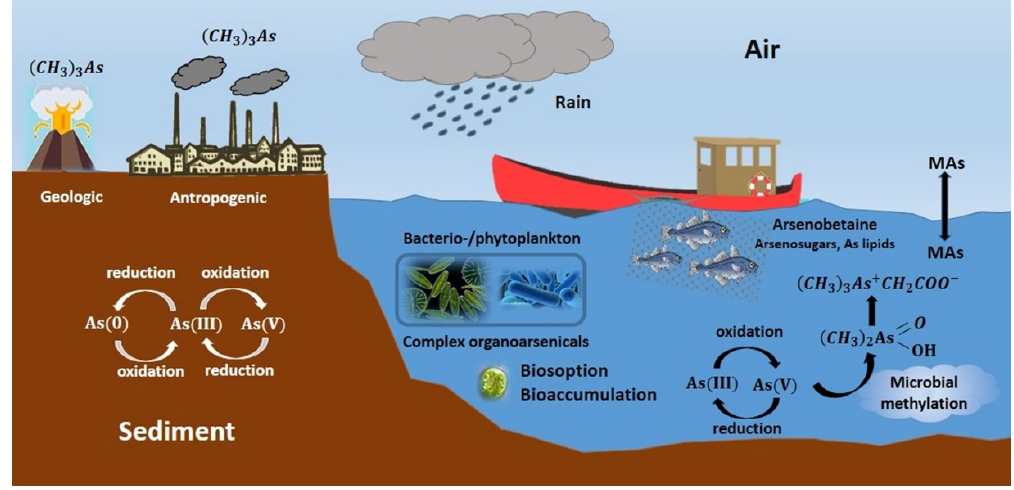
Figure 3. Microbial transformations in the biogeochemical cycle of Arsenic. (CH3)3As: trimethylarsine. Mas: methyl arsenic. Figure inspired from those published by Yüksel et al. and Bhattacharya and Ghosh [86,87].